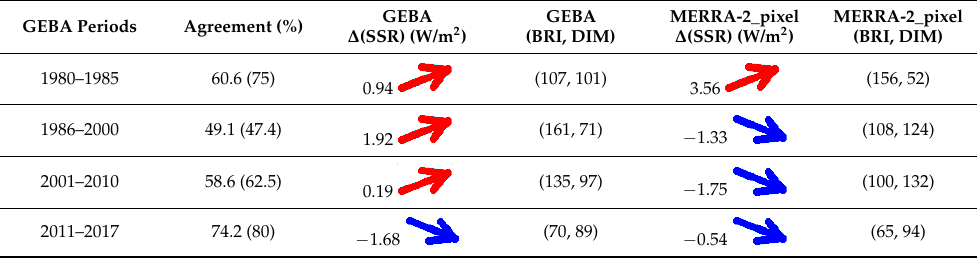
Table 3. As in Table 2, but for BSRN stations.